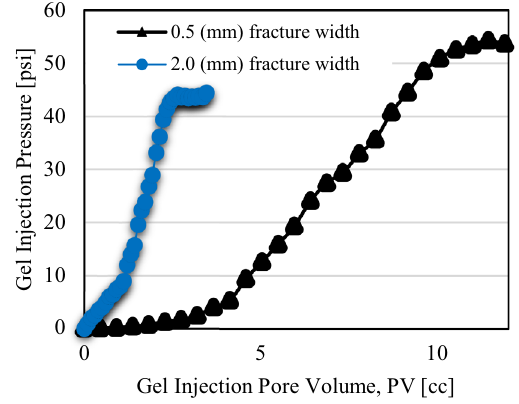
Fig. 12 Particle gel injection in 0.5 mm and 2.0 mm fracture width using 1450 pa gel